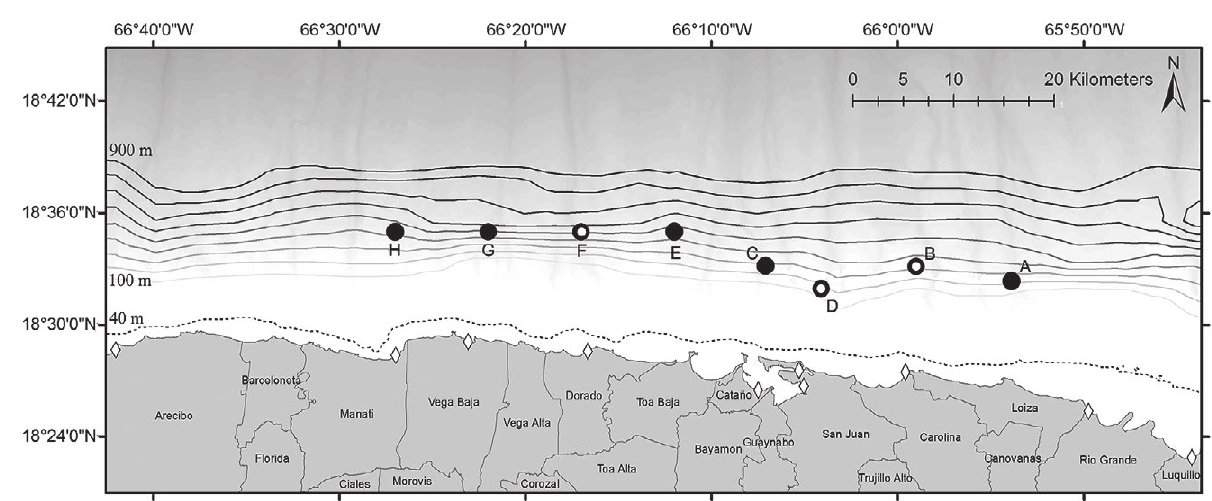
Fig. 1. – FADs were deployed in a linear array from Loiza to Manati off San Juan, Puerto Rico. White circles within a black oval indicate the location of time-lapse cameras; white diamonds indicate the locations of marinas, docks or boat ramps where vessels access the ocean; municipalites along the north coast of Puerto Rico are labelled by